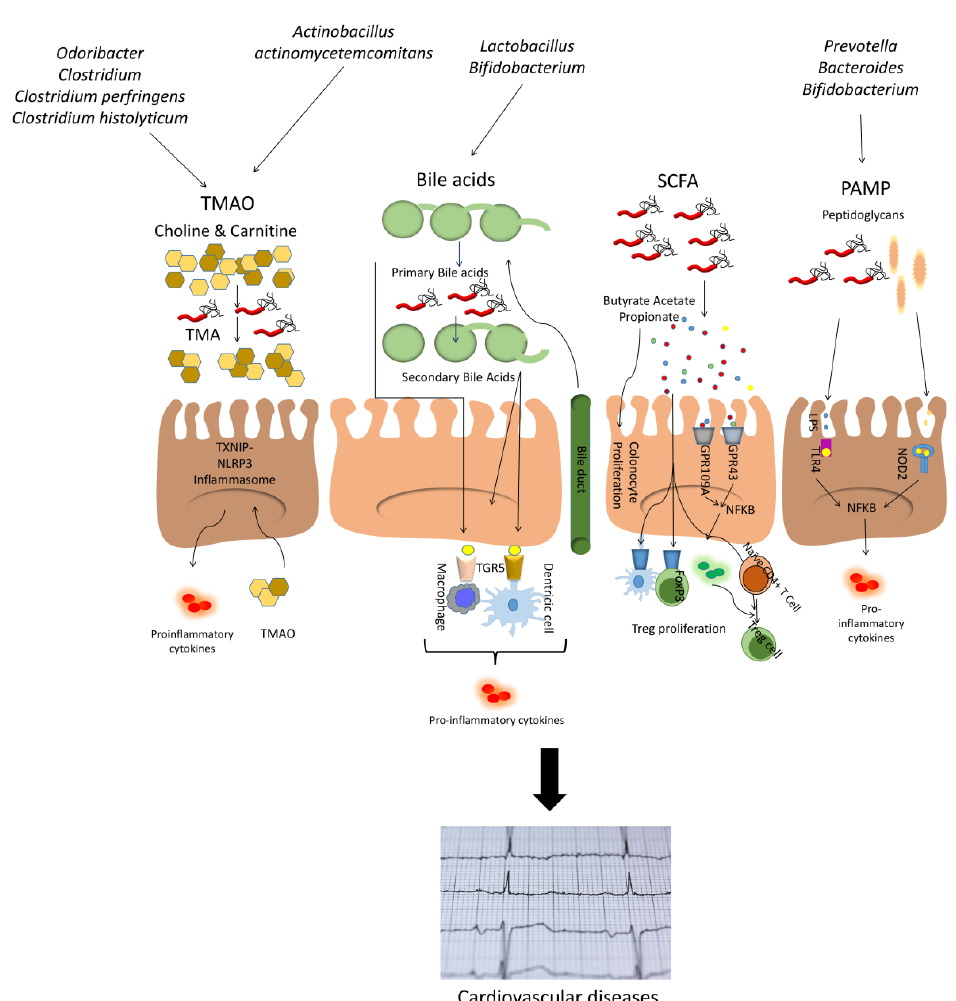
Figure 1. Schematic representation of the relationships between microbiota and cardiovascular disease (CVD). Abbreviations. LPS, lipopolysaccharide; PAMP, pathogen-associated molecular patterns; NFκB, nuclear factor kappa-B; SCFA, short-chain fatty acids; TLR, toll-like receptor; TMAO, trimethylamine N-oxide.